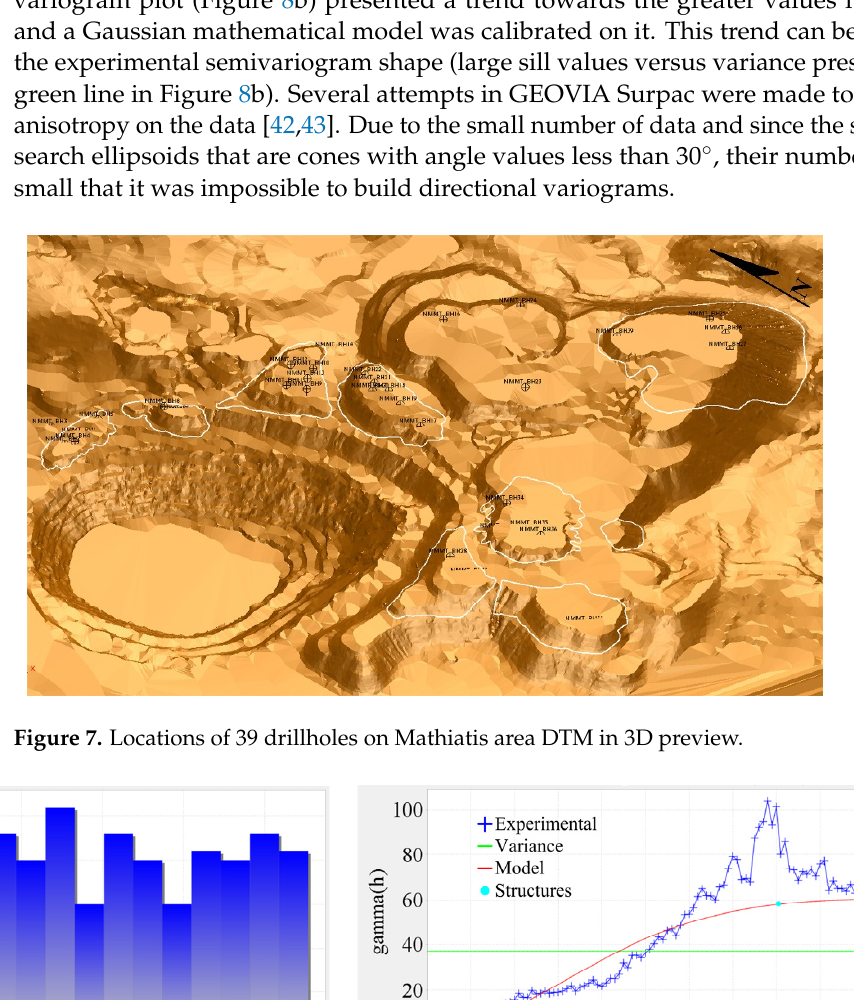
Figure 8. ( a ) Histogram and ( b ) experimental semivariogram of raw elevation data.